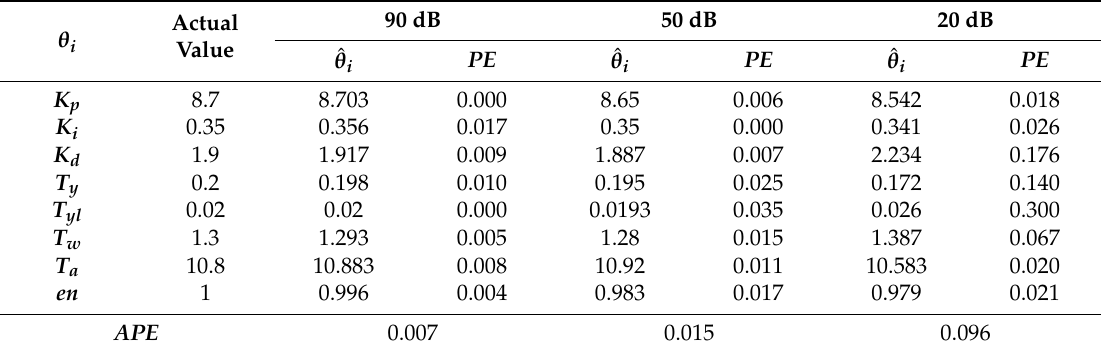
Table 3. Parameter identification results of PTGS with three different signal-to-noise